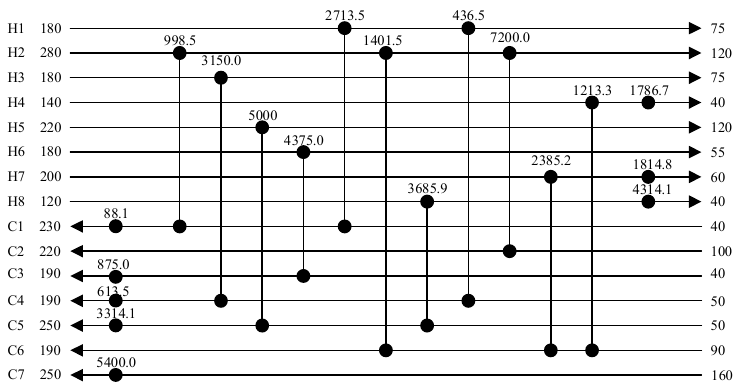
Figure 14. Results obtained using the original RWCE.